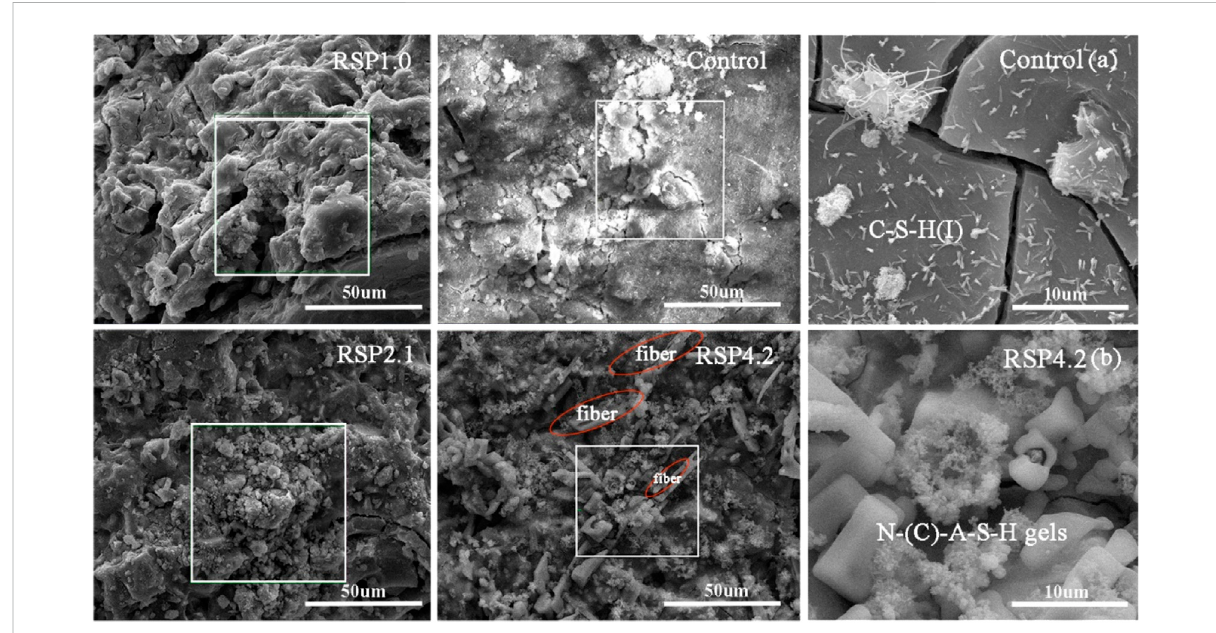
FIGURE 5 Morphologies of (A) control and (B) RSP4.2 paste and EDS analysis of the AAS paste with and without RSP at 28